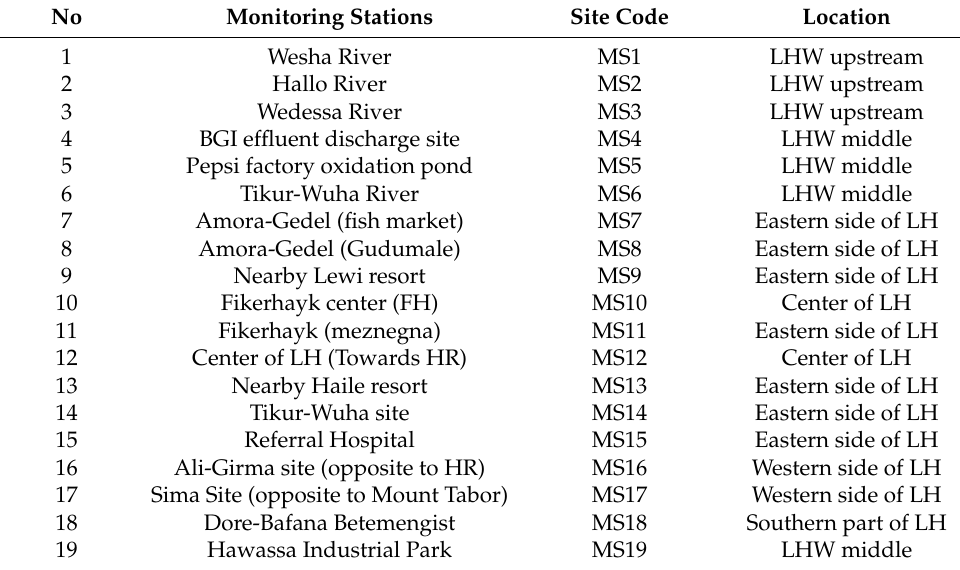
Table 1. Monitoring stations in Lake Hawassa